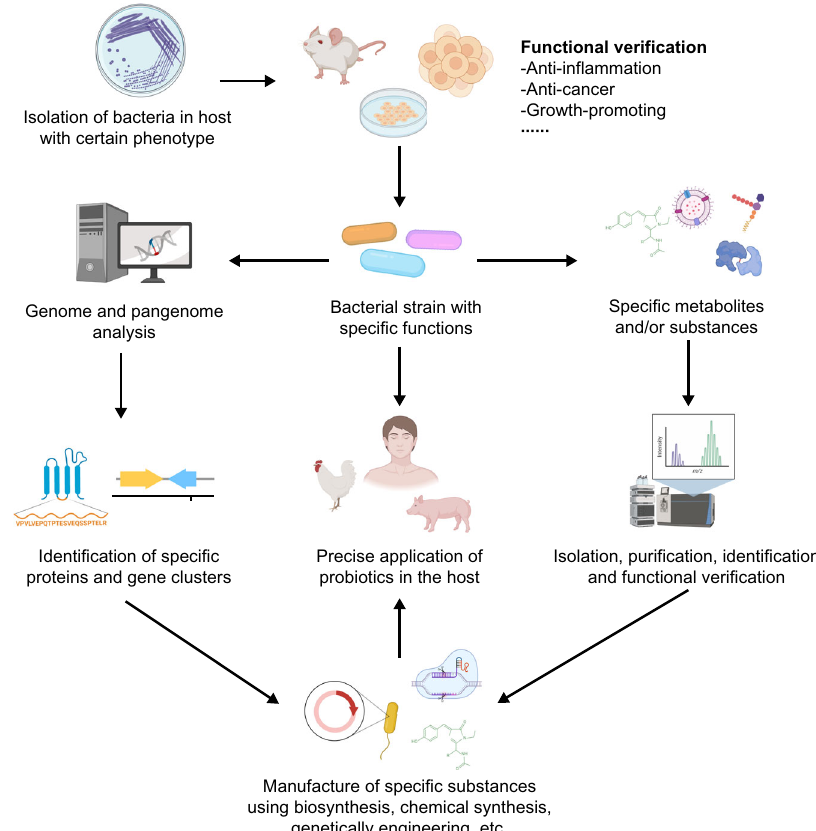
Fig. 4 A schematic diagram of work fl ow on the precise application of NGP. All fi gures are created with